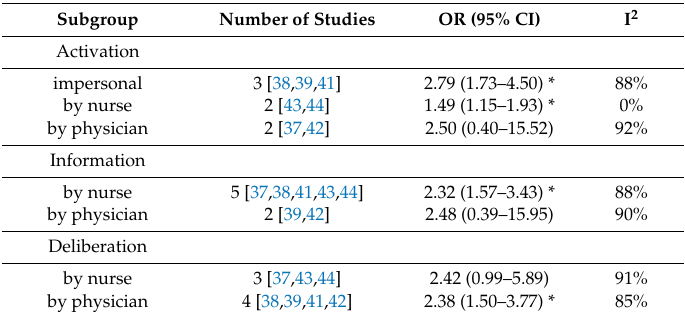
Table 2. Subgroup analyses